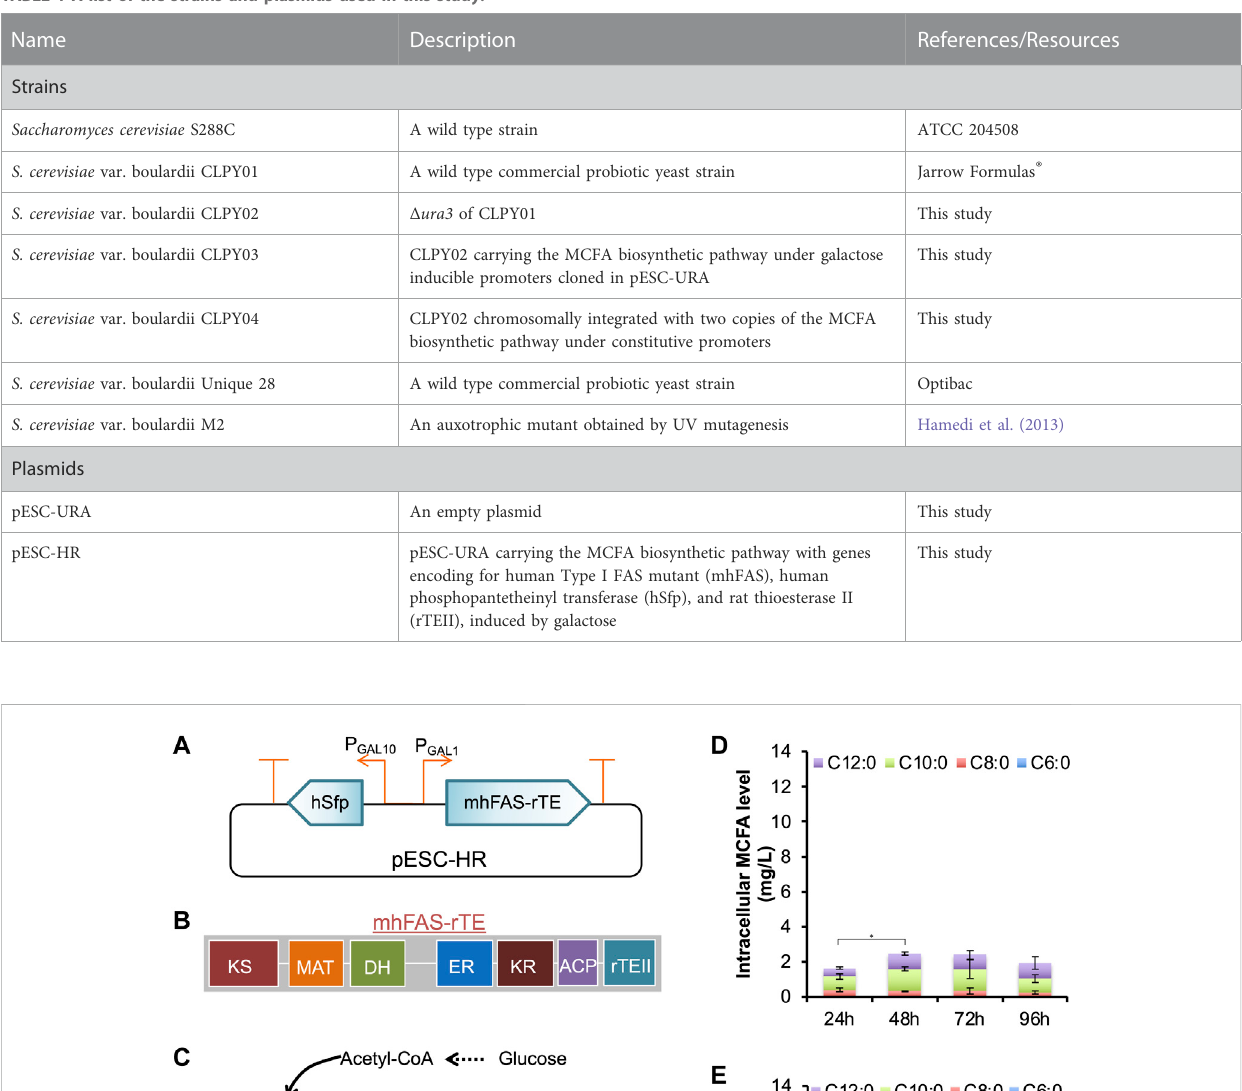
TABLE 1 A list of the strains and plasmids used in this study.